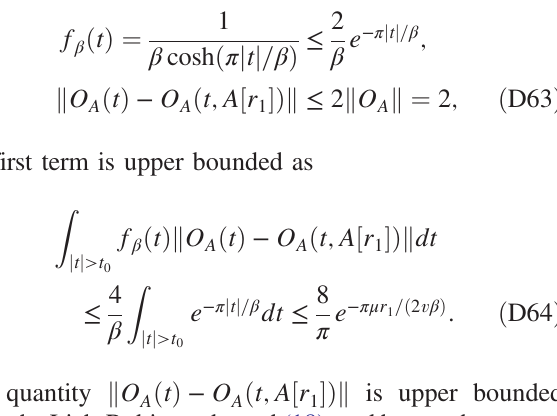
FIG. 4. Approximations of L and L . To obtain the O A O B ˜ L ˜ L approximations and , which commute with each other, O A O B L and L are approximated onto the extended regions A ½ r 1 (cid:2) O A O B and B ½ r 2 (cid:2) ( r 1 þ r 2 < R ), respectively. In Eqs. (D59) and (D60), the explicit forms of L and L are O A O B